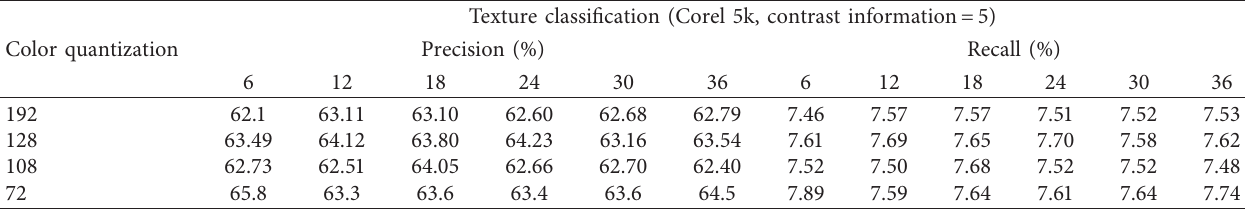
Table 1: Average retrieval precision and average retrieval recall of NRLGO at varying values of gradient orientation and color quantization levels by keeping local contrast information fixed at 5 on Corel 5k in HSV.